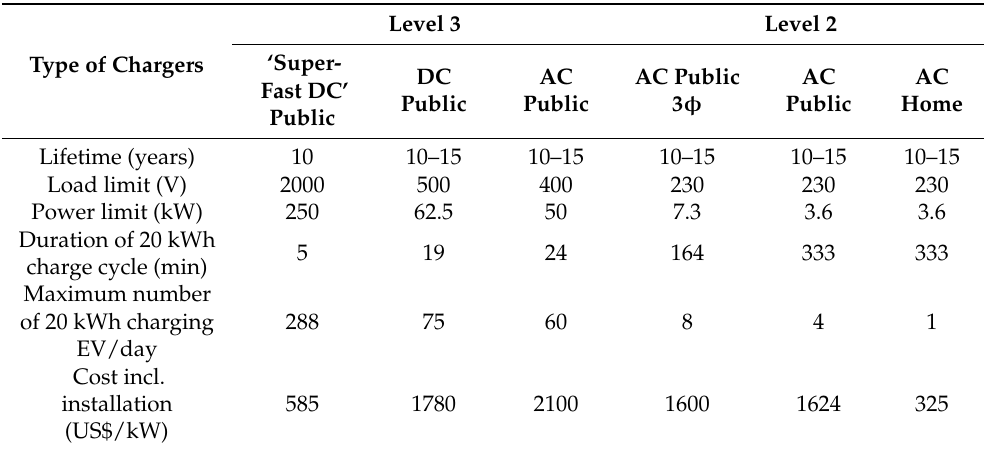
Table 2. EV chargers specifications